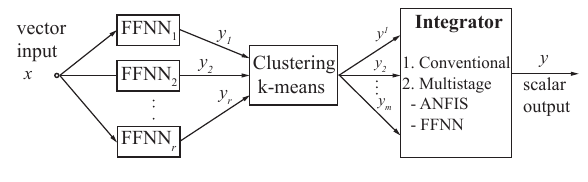
Figure 7: Proposed neural network